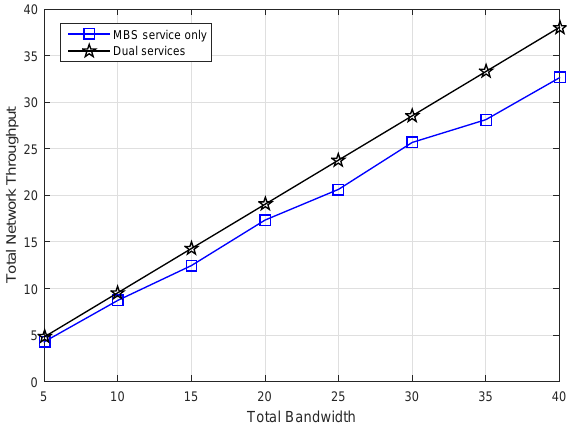
Figure 14. Overall network throughput under different service